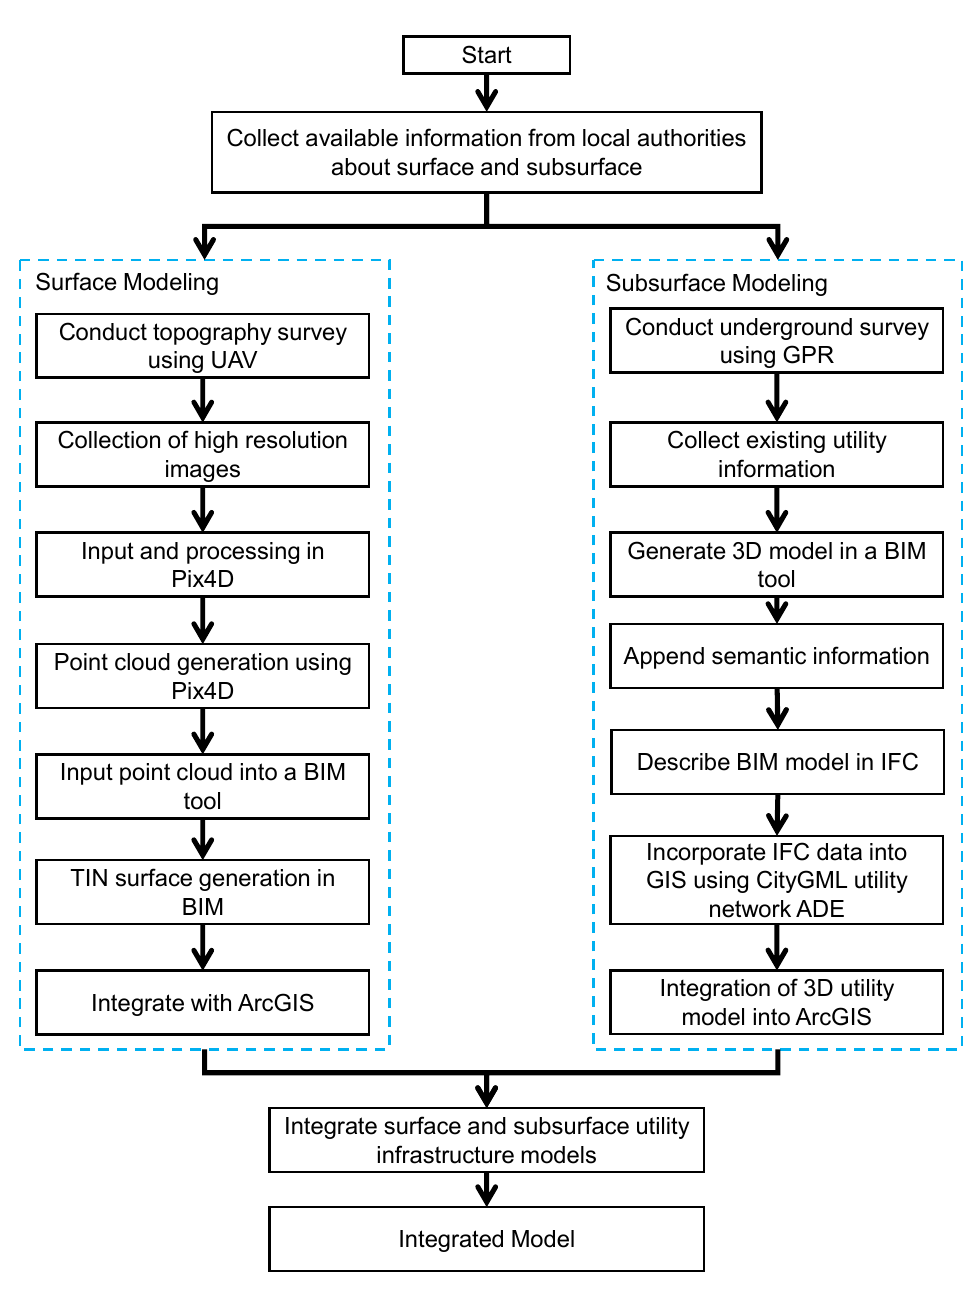
Figure 13. The process of developing surface and subsurface utility infrastructure model.